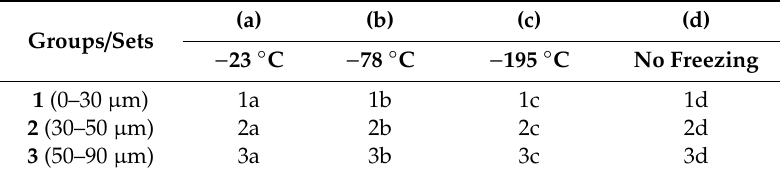
Table 1. Notation of the pHPMA hydrogel samples according to the sample preparation conditions for the visualization of the hydrogel morphology by SEM and LSCM.